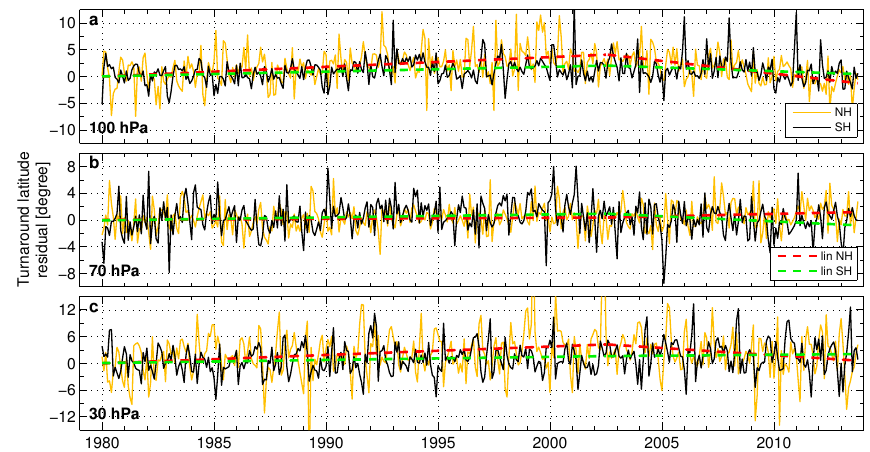
Figure 6. Fit residuals (excluding linear terms) of turnaround latitudes determined from EI upwelling mass fluxes at different pressure levels ( a 100hPa; b 70hPa; c 30hPa). The black and orange lines denote the fit residuals whereas the red and green dashed lines depict the resulting linear trends in the Northern and Southern Hemisphere (NH/SH), respectively.